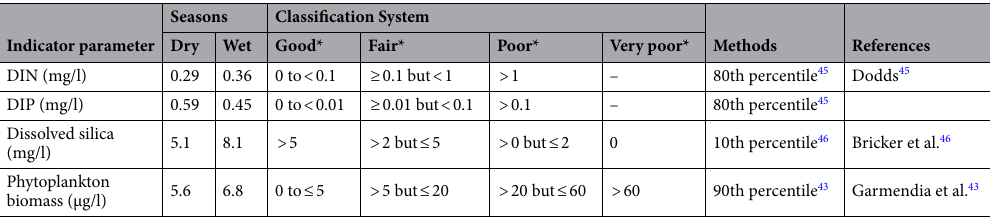
Table 2. Indicator threshold values to classify the trophic status of the Meghna River estuary. *Good = Oligotrophic; Fair = Mesotrophic; Poor = Eutrophic; Very poor = Hypereutrophic; UE = Upper estuary, ME = Middle estuary, LE = lower estuary, CK = Char Kukrimukri, HI = Hatiya Island.